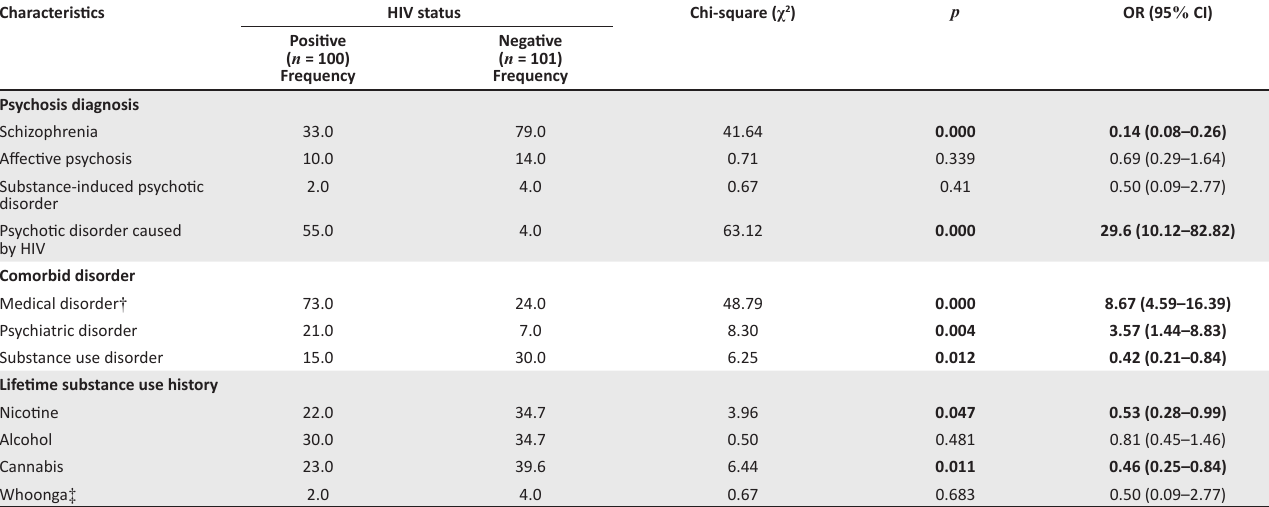
TABLE 2: Association between human immunodeficiency virus status and clinical variables ( n = 201). Characteristics